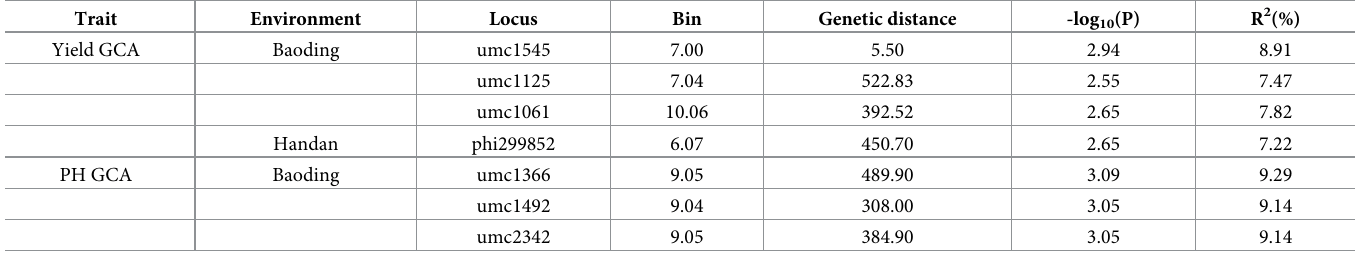
Table 6. Marker loci associated with GCA of GY, PH, EH.